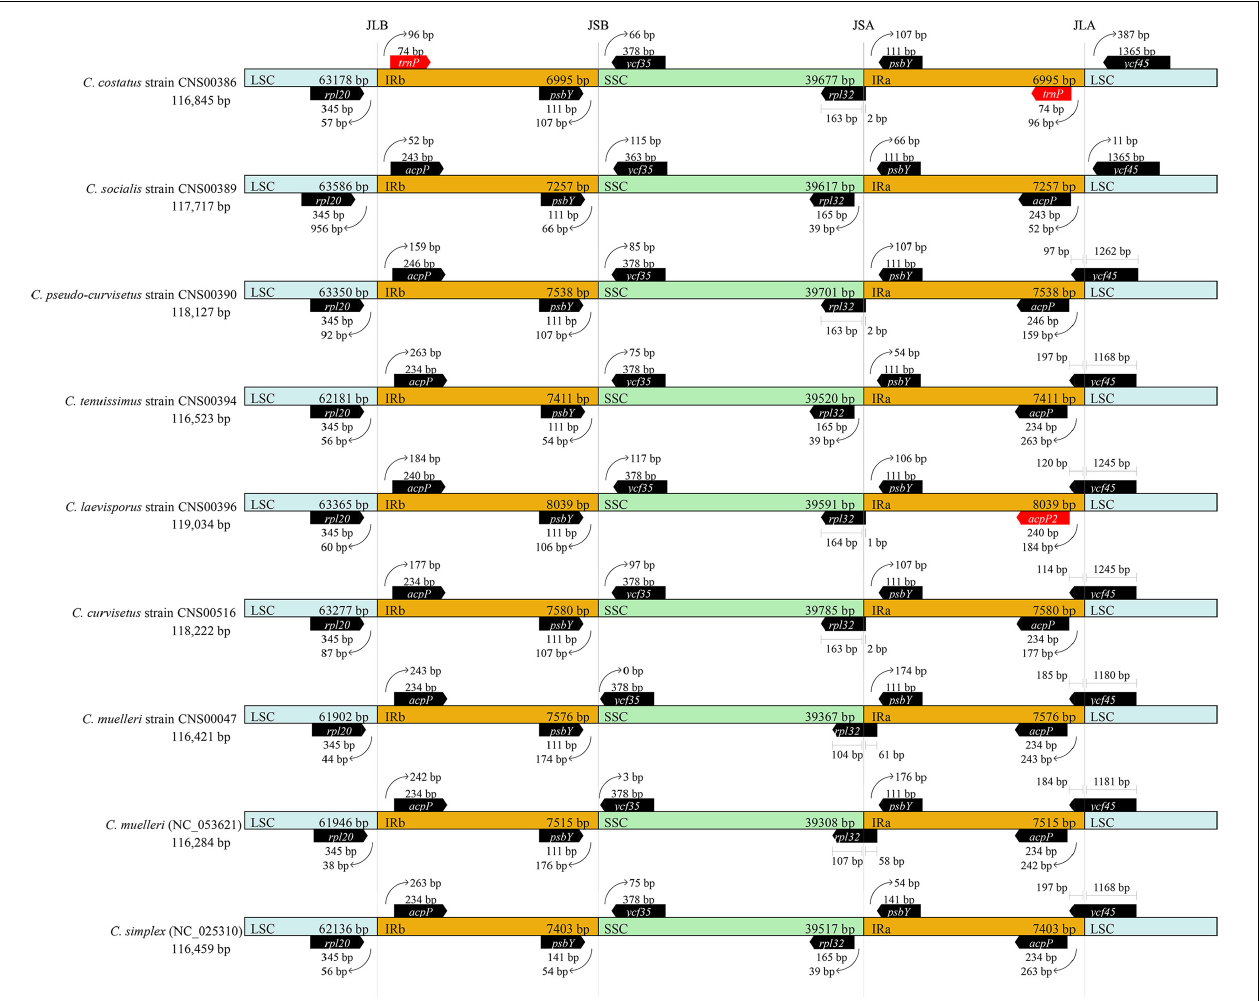
FIGURE 5 | Comparison of the junctions between the LSC, SSC, and IR regions among Chaetoceros cpDNAs.